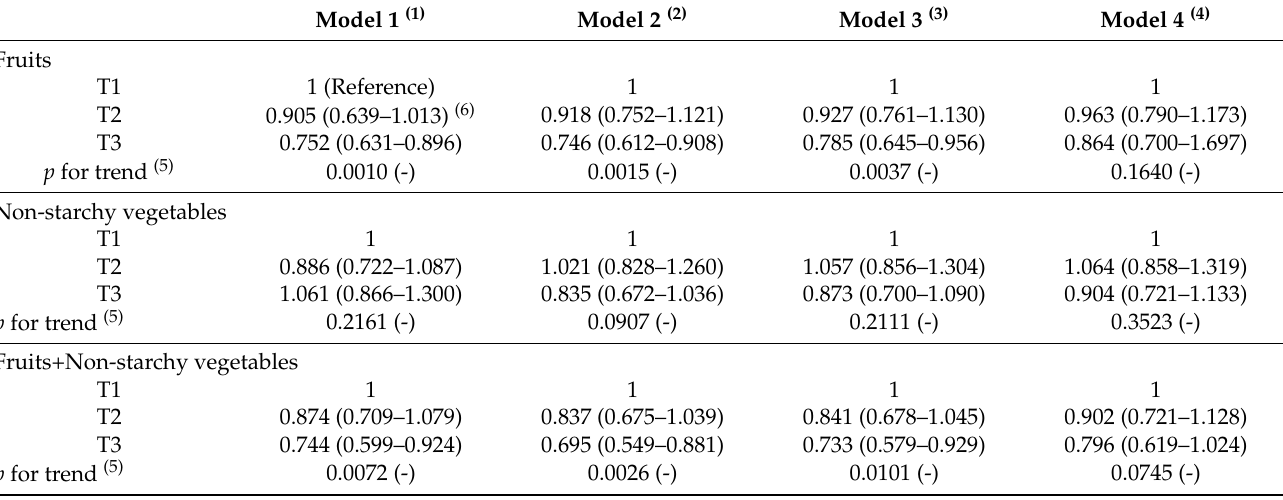
Table 8. Relationship between prevalence of periodontal disease and plant food